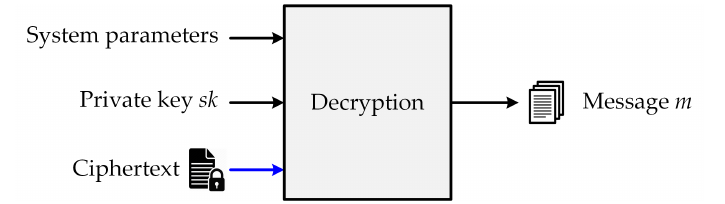
Figure 3. Decryption process of a public-key